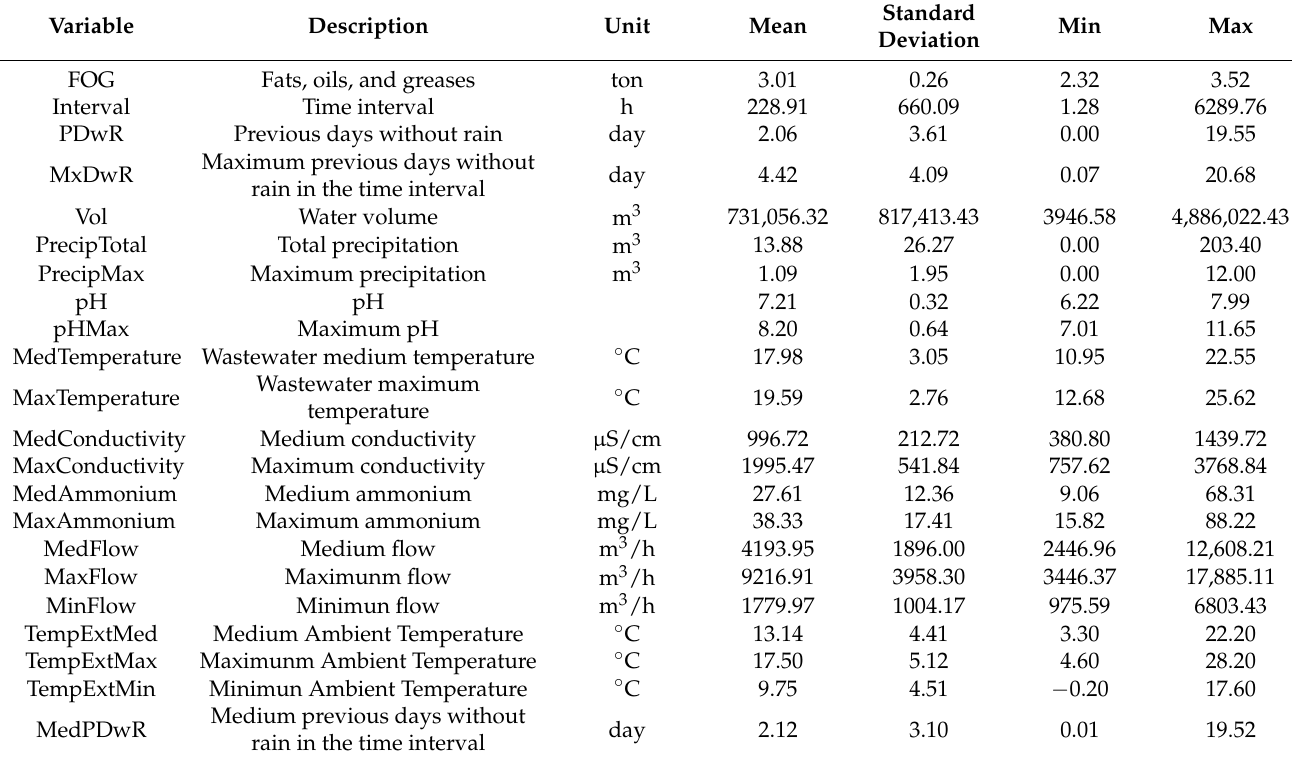
Table 2. Statistical description of the